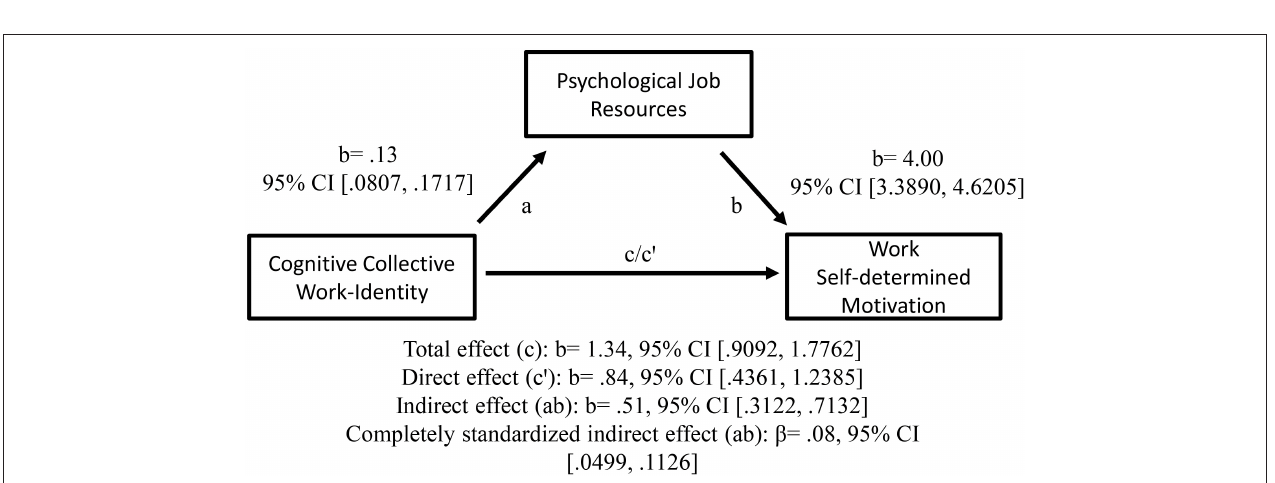
FIGURE 6 | Cognitive collective work-identity as a predictor of work self-determined motivation, mediated by psychological job resources. The confidence interval (CI) for the indirect—and completely standardized indirect effect is a BC bootstrapped CI based on 5,000 samples.